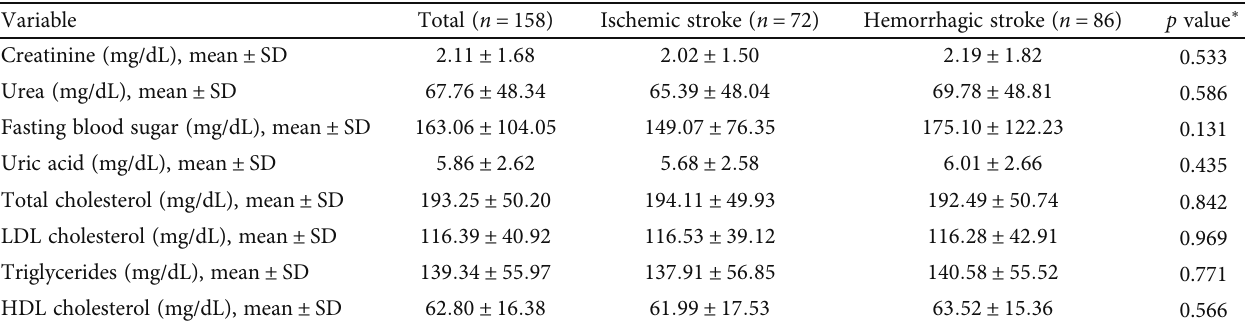
Table 4: Comparison of mean values of laboratory investigation data of patients with ischemic and hemorrhagic stroke.